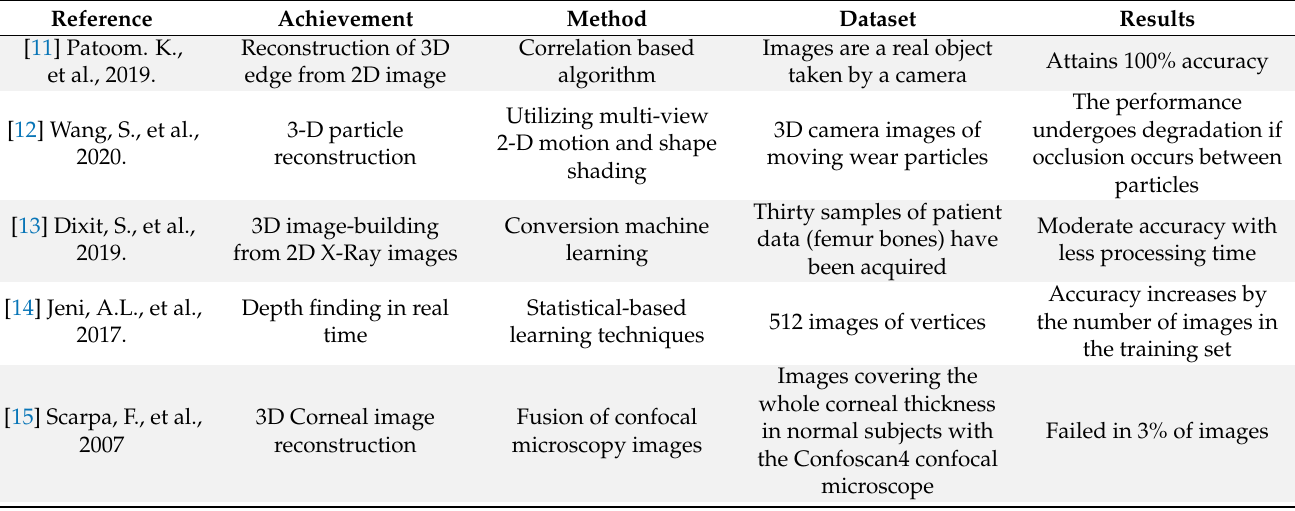
Table 2. 3D Image